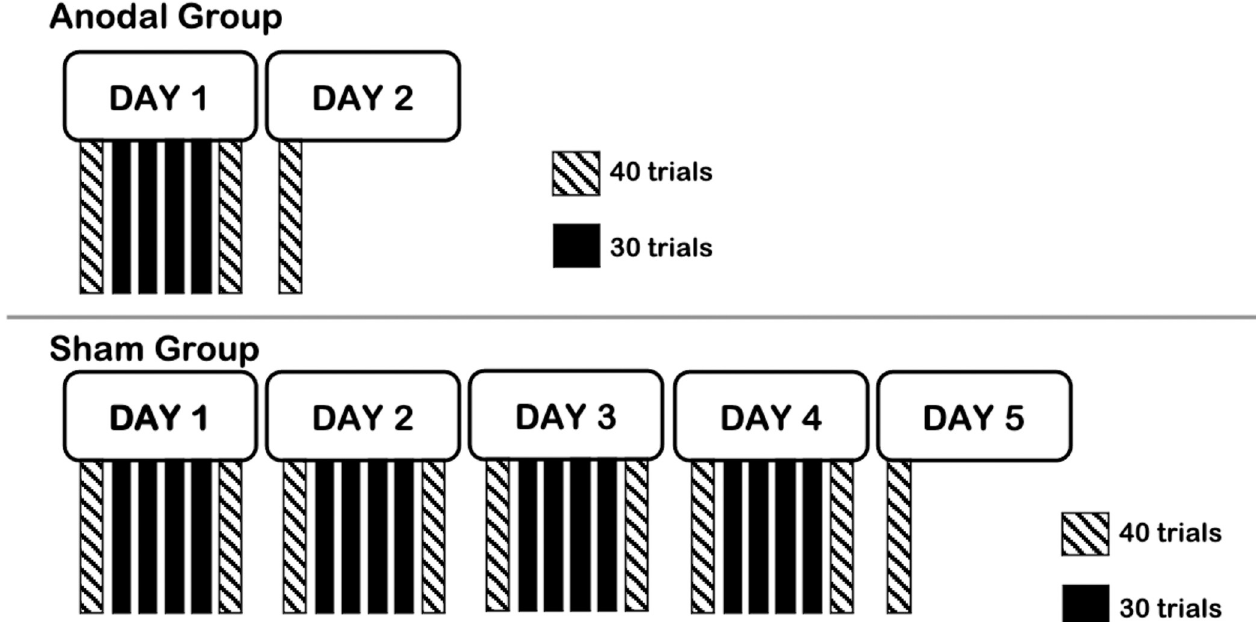
Fig 1. Study design. Study protocol for participants in the anodal and sham tDCS groups. Participants in the anodal tDCS group (Anodal Group) participated over 2 days, and participants in the sham tDCS group (Sham Group) participated over 5 days. In each day, participants performed the sequential visuomotor isometric pinch force task (SVIPT) with and without tDCS. Each black bar represents one block of practice that comprised 30 trials of practice on the SVIPT, with tDCS (anodal or sham) applied concurrently. Each hatched bar represents one block of practice that comprised 40 trials where no tDCS is applied.